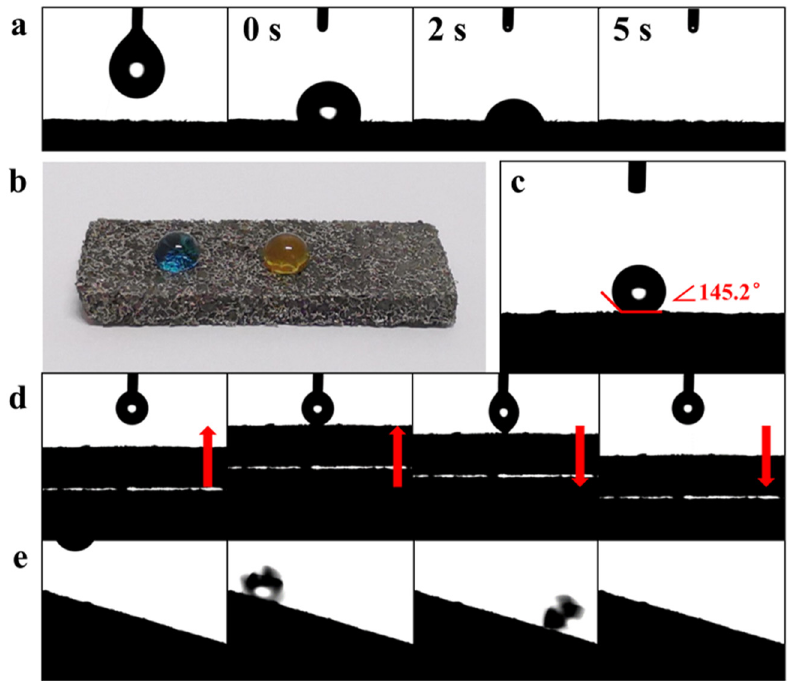
Figure 6: Surface wettability of Ni/GO/PVA - 20 aerogel: ( a ) before hydrophobicity modi fi cation; ( b and c ) contact angle after hydrophobic modi fi cation; ( d ) droplet drag experiment; ( e ) rolling angle